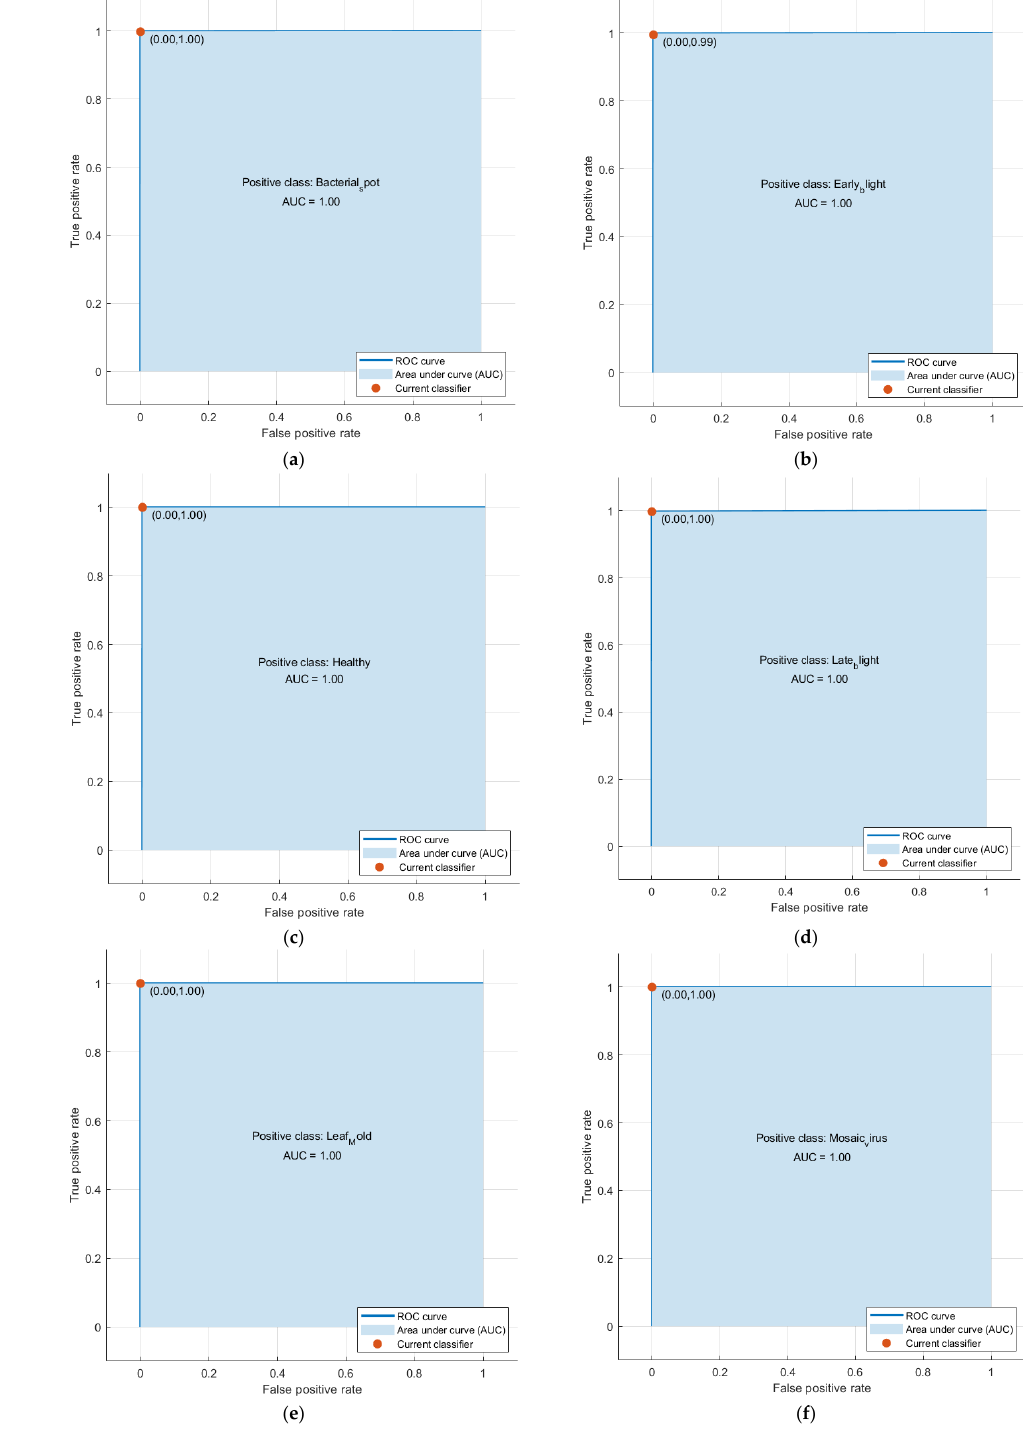
Figure 5. The ROC curves for the KNN classifier after feature selection using the bidirectional search methodology. ( a ) Bacterial Spot. ( b ) Early Blight. ( c ) Healthy. ( d ) Late Blight. ( e ) Leaf Mold. ( f ) Mosaic